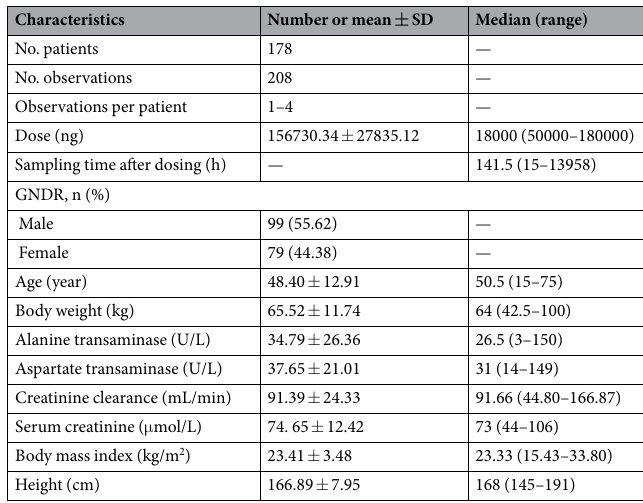
Table 1. Demographic background and clinical characteristics of the subjects for